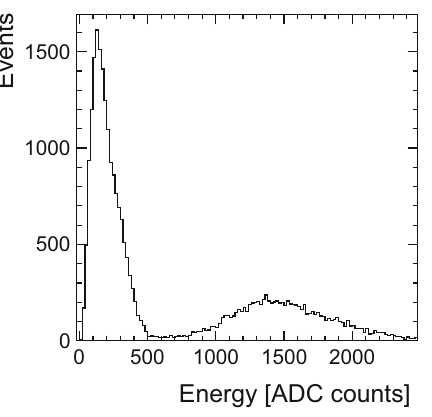
Fig. 14 Energy deposition in the calorimeter for a beam comprising electrons and muons